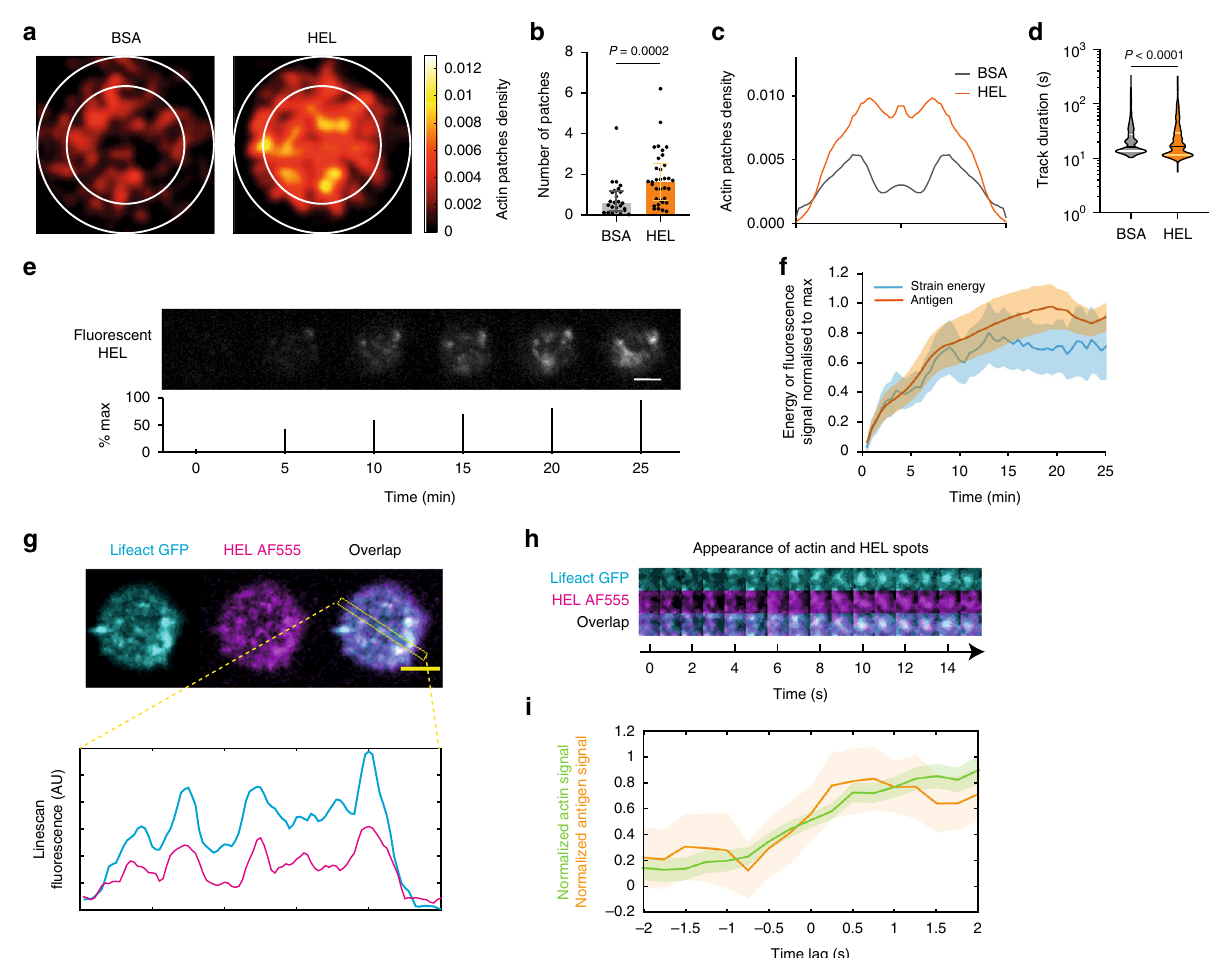
Fig. 7 Actin patches correlate with antigen Internalization. a Average distribution of actin patches (obtained by tracking and convoluting the results with a Gaussian kernel): internal circle (2/3 cell diameter) corresponds to the central portion of the cell (scale bar represents the integrated density as number/ cell/5 min). The distribution in HEL-coated gel is very different compared with the BSA coated gel in b number of beads (Mann – Withney test, Median ± IQR) and c radial distribution (BSA: 25 cells, HEL: 34 cells, three different mice). d Effective diffusion coef fi cient of actin patches (violin plot with Median±IQR, n = 301 trajectories (34 cells) for HEL and n = 84 trajectories (25 cells) for BSA, Mann – Whitney test). e Time lapse of the extraction of fl uorescent HEL (below: percentage of the maximum, scale bar 3 µ m). f Strain energy and antigen gathering (Mean ± SEM, n = 15, fi ve independent experiments); signals are normalized to the maximum to highlight similarity in the kinetics. g Example of colocalization of the actin patches (lifeact-GFP) and fl uorescent HEL (AF555), bottom linescan on the colocalization panel (scale bar 3 µ m). h Zoom on an actin (and HEL) patch showing the concomitant arrival of the two signals. i Quanti fi cation of the signal in g measured over a square of 1 µ m × 1 µ m: both signals appear simultaneously (mean± SEM, n = 21, from six cells). Source data are provided as a Source Data fi